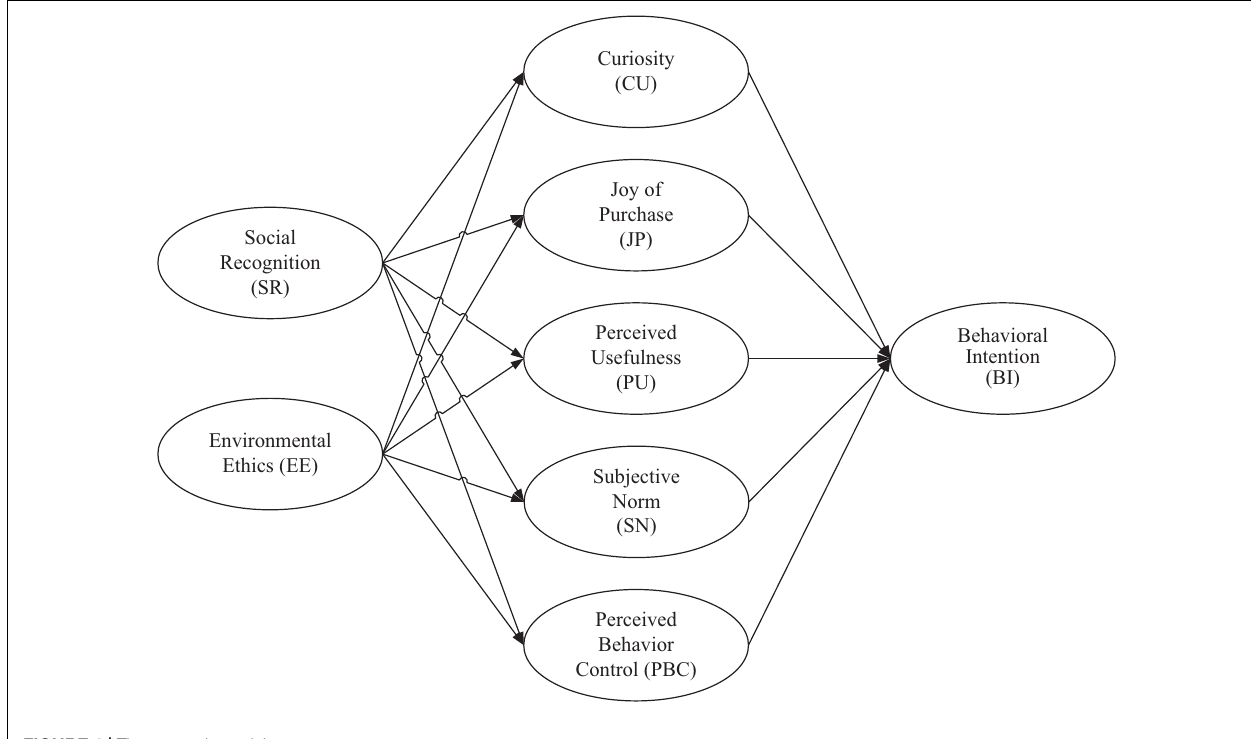
FIGURE 1 | The research